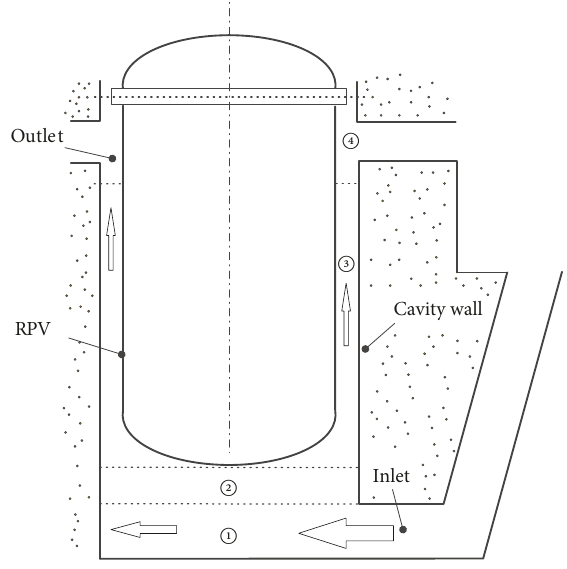
Figure 5: Cavity